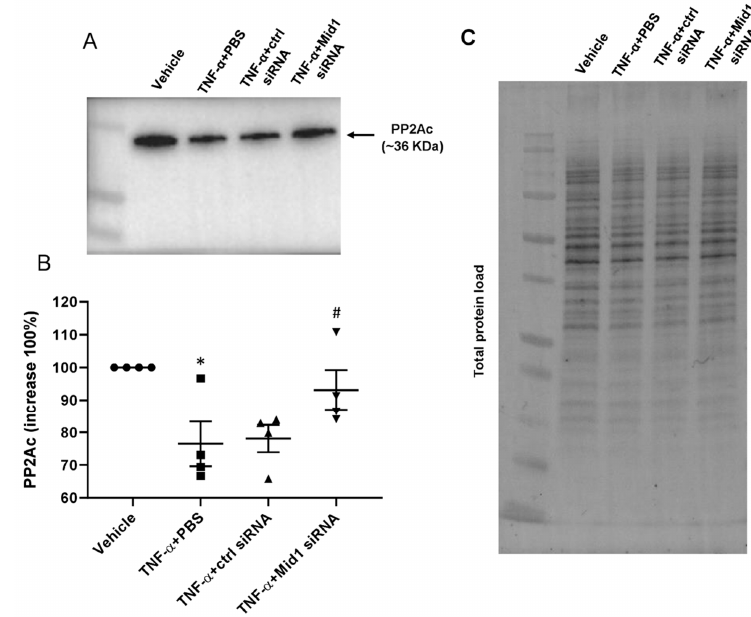
Figure 5. Mid1 regulates PP2Ac expression. eEnd.2 cells were transfected with 100 nM negative control siRNA or Mid1 siRNA for 24 h, then stimulated with 100 ng/mL TNF- α for 1 h. ( A ) PP2Ac expression was examined by Western blot. ( B ) Increase percentage of PP2Ac after normalization with total protein load in each well. ( C ) Total protein load used to normalize PP2Ac bands. Data are mean ± SEM and n = 4. * p < 0.05 vs. Vehicle, # p < 0.05 vs. TNF- α + Control siRNA.